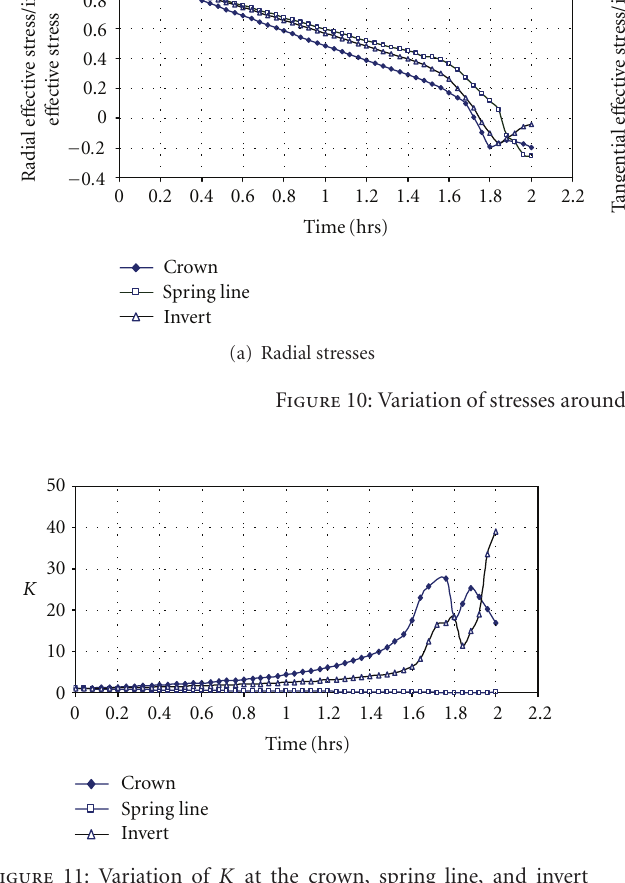
Figure 11: Variation of K at the crown, spring line, and invert during the excavation of the tunnel.